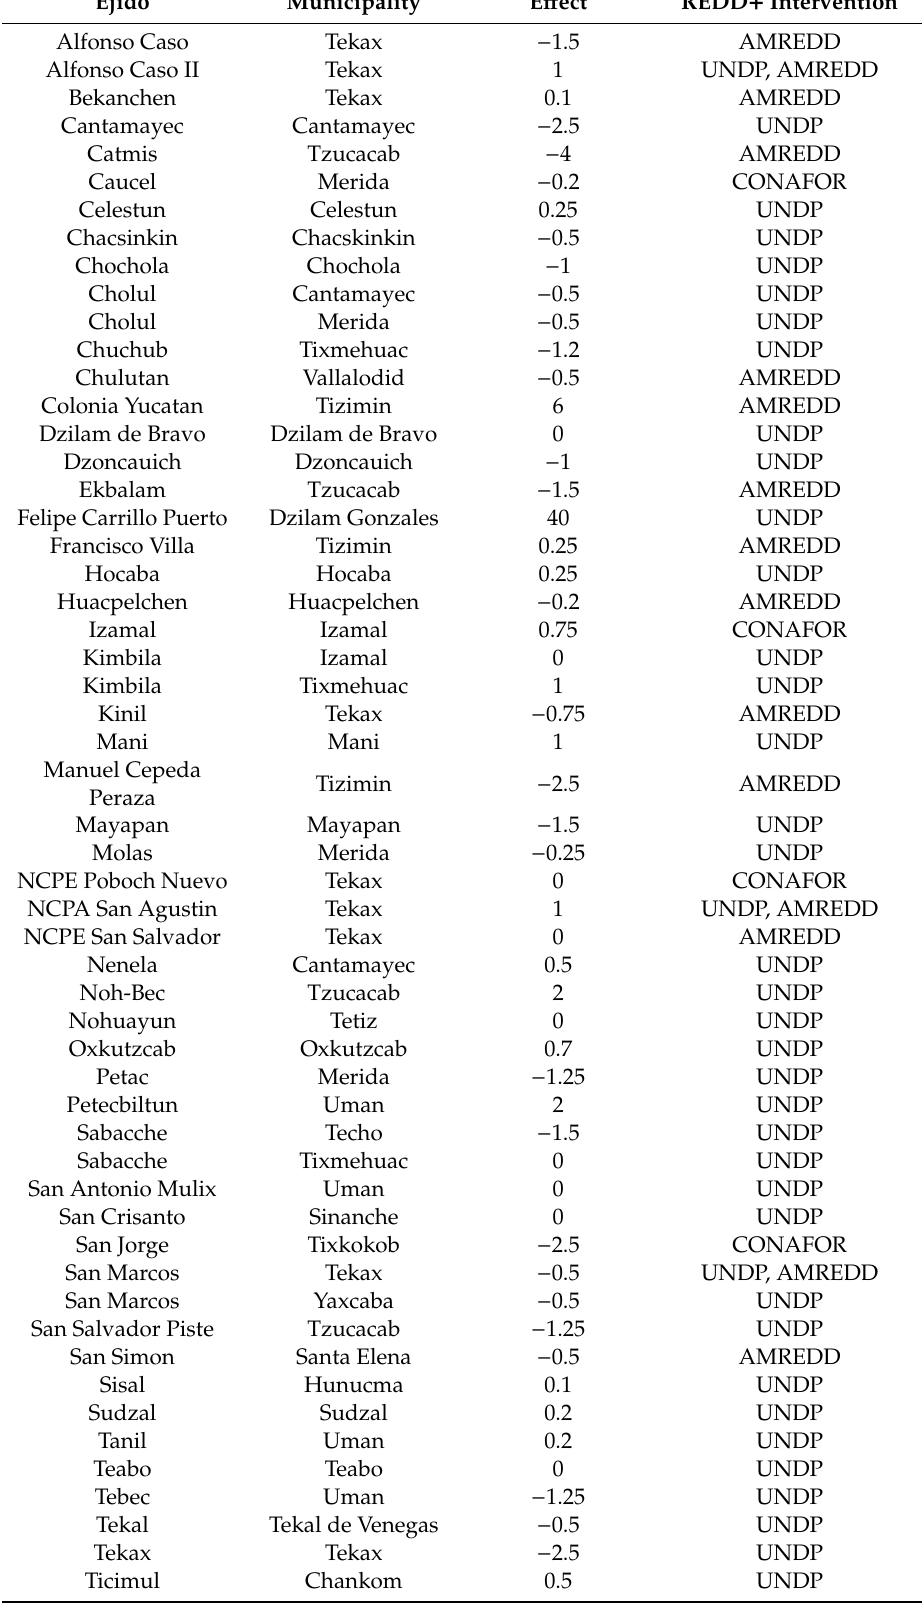
Table A2. Synthetic Control Method (SCM) results of treated unit e ff ects for each REDD + community (ejido) in the state of Yucatan (CONAFOR = National Forestry Commission, UNDP = United Nations Development Program, AMREDD = Mexico REDD +